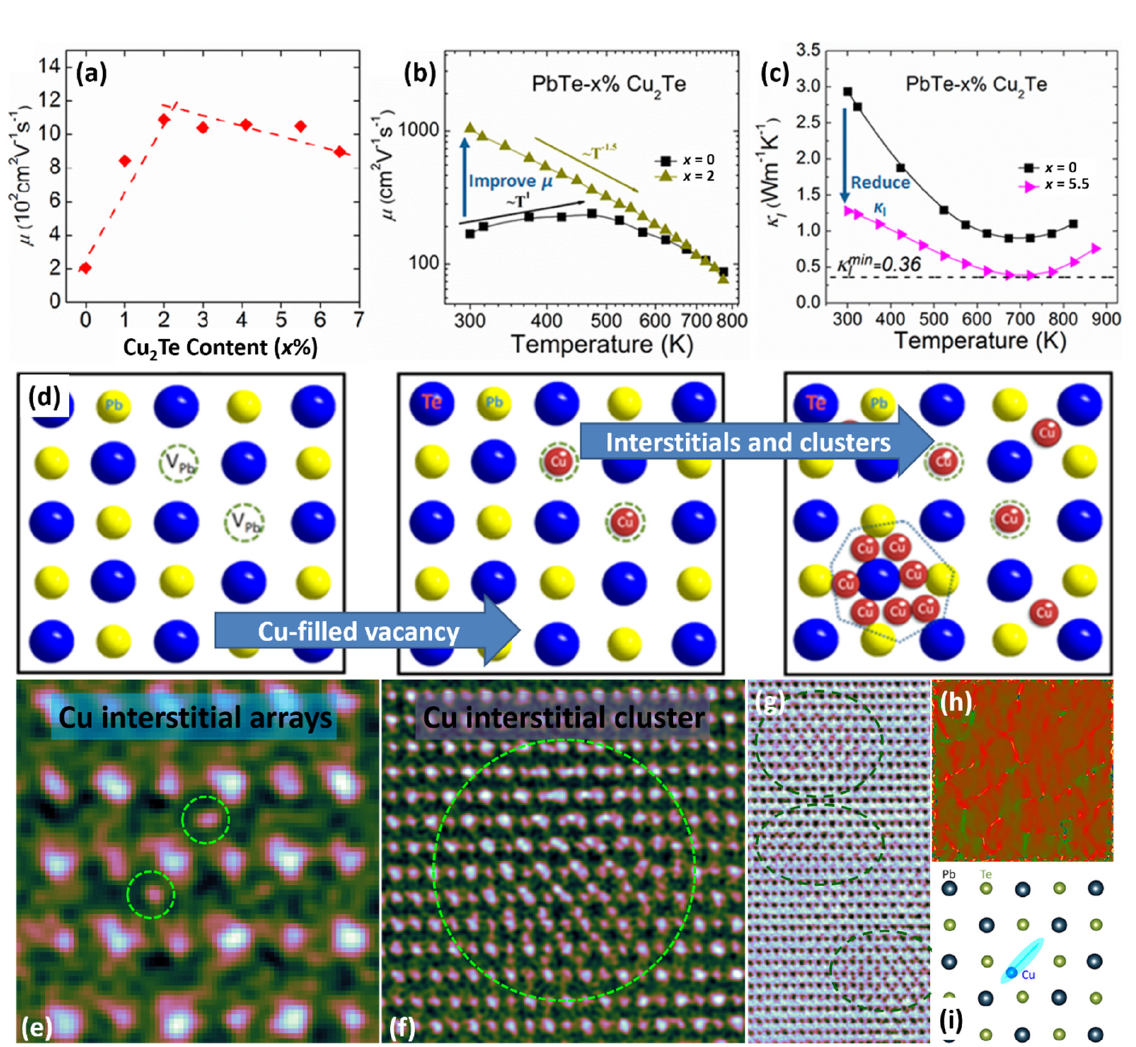
Figure 8. Synergistic role of copper in achieving high thermoelectric performance of n-type PbTe- Cu 2 Te. ( a ) Experimental and calculated carrier concentration and ( b ) carrier mobility as a function of Cu 2 Te. ( c ) Carrier mobility and lattice thermal conductivity are improved simultaneously through introducing Cu into the n-type PbTe. ( d ) Schematic of Cu atom occupying Pb vacancy. ( d ) The intrinsic Pb vacancies were firstly filled with Cu atoms to enhance carrier mobility, and then the excess Cu atoms formed voids and precipitations to decrease the thermal conductivity of the lattice. Atomic-scale defects for optimizing electrical and thermal transport via introducing Cu into n-type PbTe. ( e , f ) Atomically-resolved STEM HAADF images (colorized) showing Cu interstitial arrays and Cu interstitial clusters. ( g ) Atomically-resolved STEM ABF image showing three Cu interstitial clusters. ( h ) GPA strain analysis. ( i ) Schematic of a Cu atom vibrating around a Pb vacancy. Reproduced from Ref. [4] Copyright 2017 American Chemical Society.